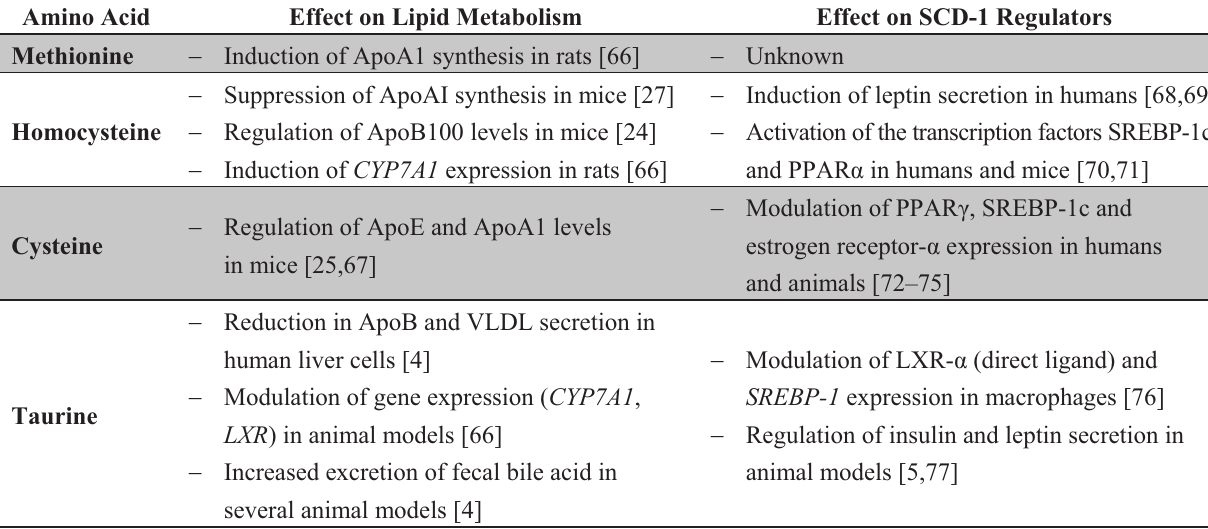
Table 2. Proposed mechanisms by which sulfur amino acids influence lipid metabolism and may potentially regulate SCD-1